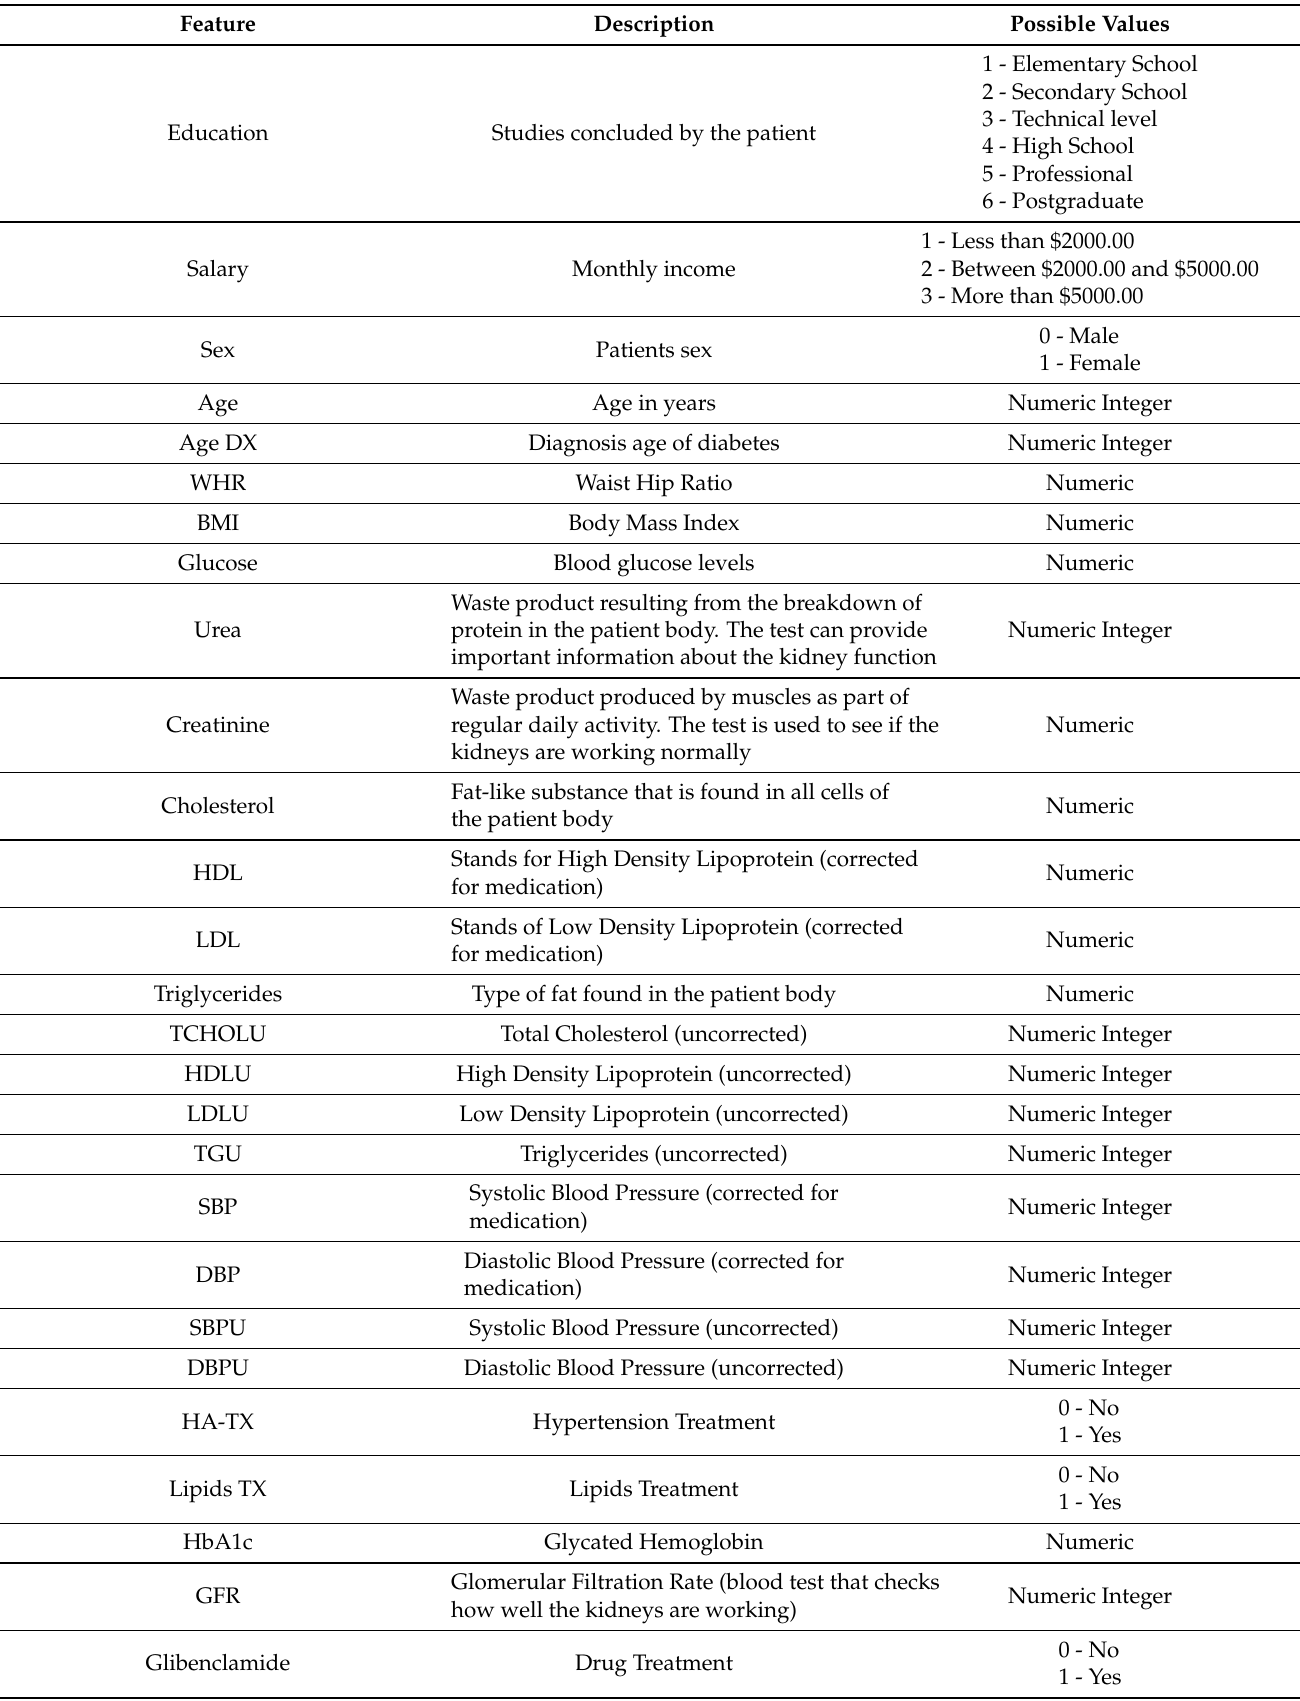
Table 1. Features